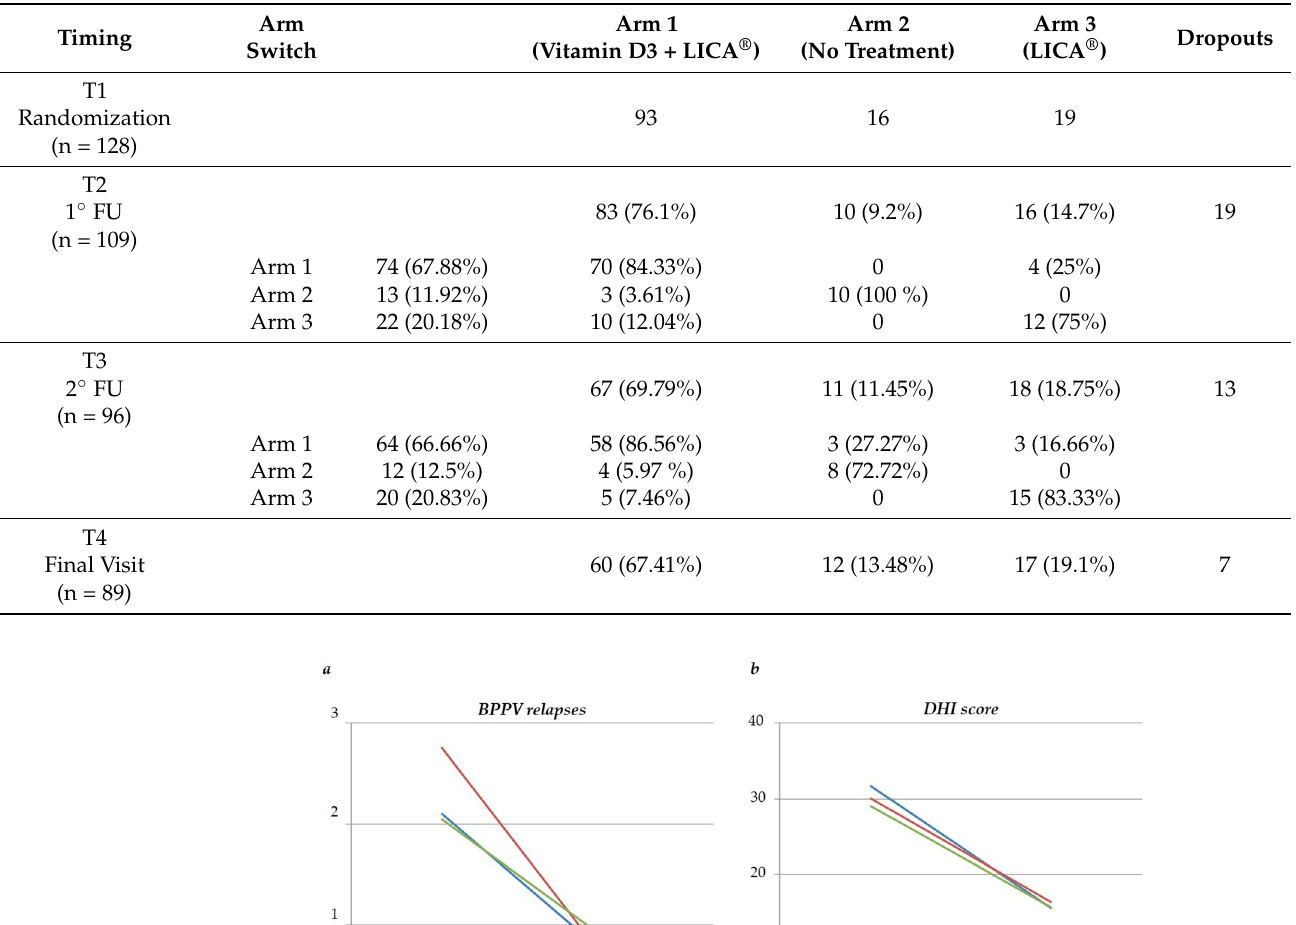
Table 2. Composition of the study population in absolute numbers and percentages of patients at the time of randomization, during the two follow-up visits, and at the final evaluation. The table shows the patients who dropped out of the study from time to time and the treatment switches. The colorimetric legend indicates the patients who have been reassigned: in green are the subjects whose 25 (OH) D values have gone from “insufficient” or “deficient” to “sufficient” and who switched into Arms 2 and 3; in red, subjects who switched in Arm 1 due to the lowering of the serum 25 (OH) D concentration (below the “sufficiency” threshold). FU: Follow up visit.